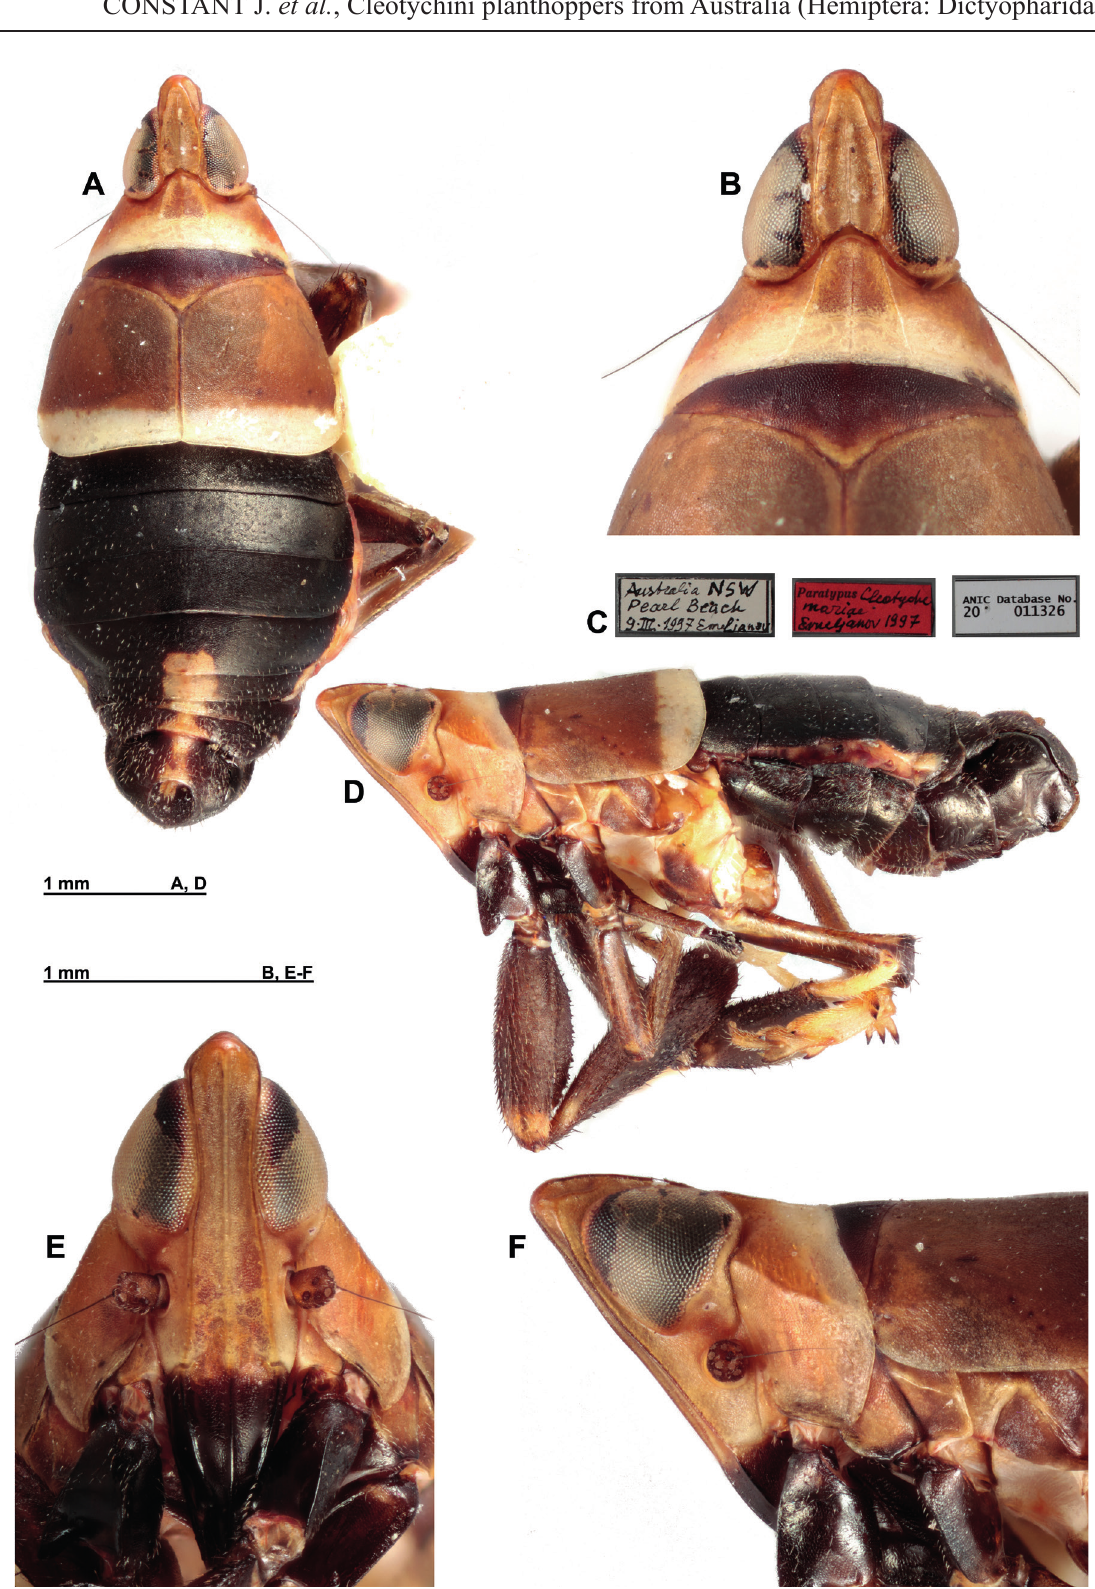
Fig. 12. Cleotyche ( Cleotyche ) mariae Emeljanov, 1997, ♀, paratype (ANIC). A . Habitus dorsal view. B . Head and thorax, dorsal view. C . Labels. D . Habitus, lateral view. E . Frons, perpendicular view. F . Head and thorax, lateral view. Photographs: © T. Pleines –